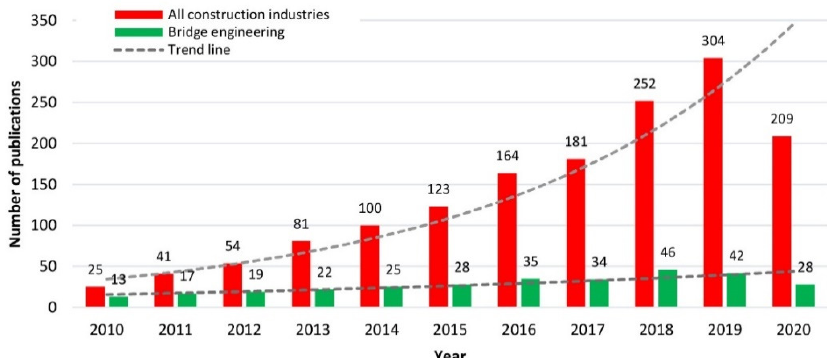
Figure 1. Flowchart of the scientometric review process.